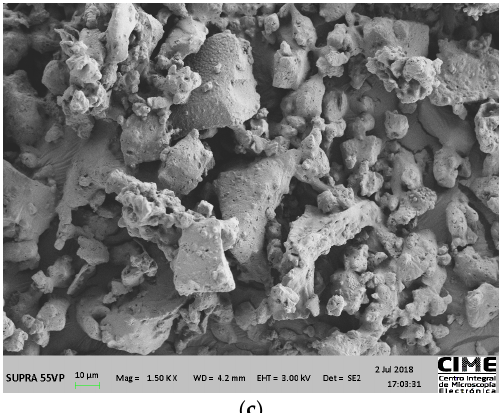
Figure 1. Scanning electron micrographs of dehydrated powders (1500X): ( a ) drying by forced circulation, ( b ) extruded, and ( c ) lyophilized.